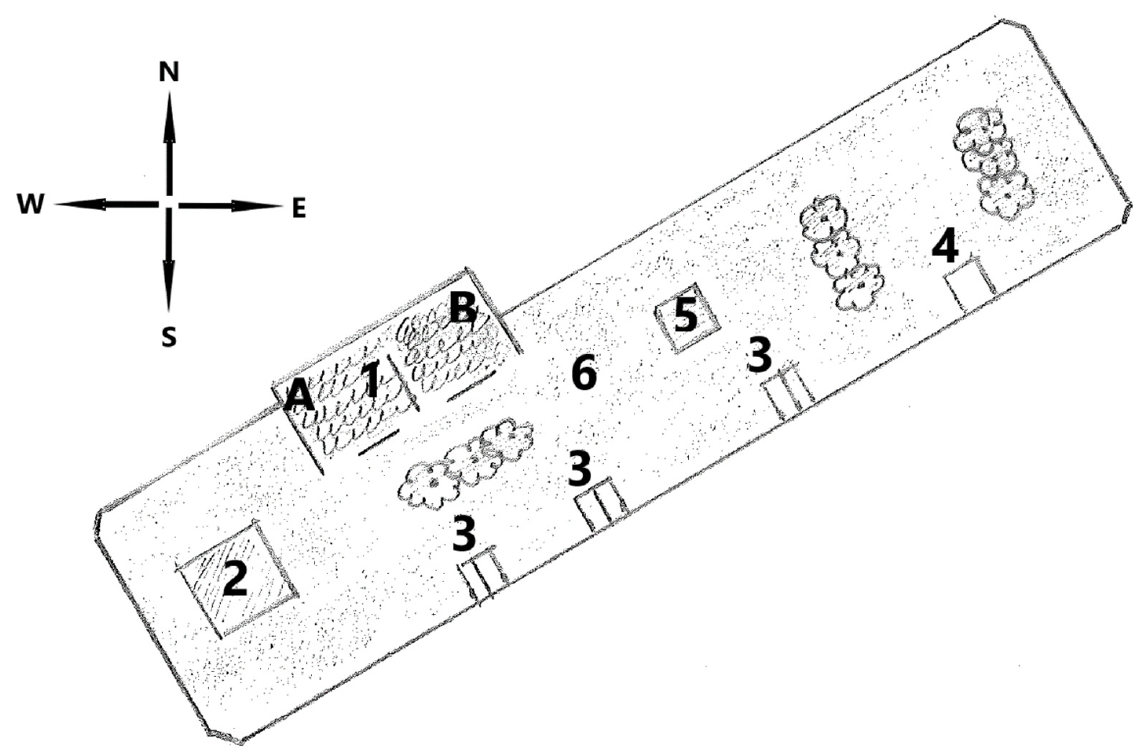
Figure 1. Detailed layout of the open barn at Flyinge in Study 1. 1: Lying hall, 2: roller pit, 3: automatic forage stations, 4: concentrate station, 5. hay bar, 6: paddock, A: camera 1, B: camera 2.